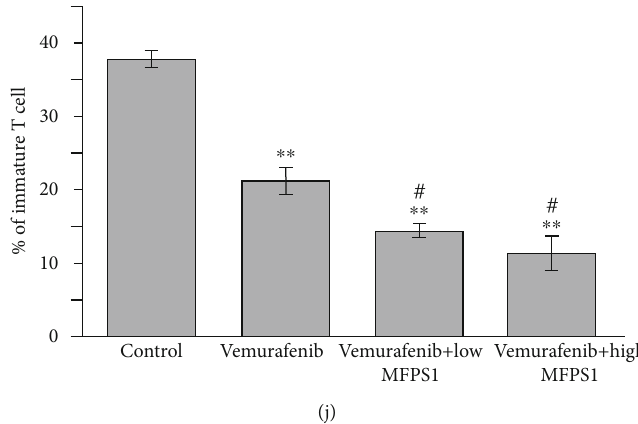
Figure 5: E ff ect of MFPS1 combined with Vemurafenib on immunomodulatory activity in melanoma-bearing mice. Results of immunophenotypic fl ow cytometry for a single mouse (a, c, e, h); (a, b) lymphocyte content in PBMCs of melanoma-bearing mice after drug treatment; (c, d) CD335-positive NK cell content in PBMCs of melanoma-bearing mice; (e, f) the content of mature B cells in PBMCs of melanoma-bearing mice (upper right corner in (e)); (e, g) the content of immature B cells in PBMCs of melanoma-bearing mice (lower right corner in (e)); (h, i) the content of mature T cells in PBMCs of melanoma-bearing mice (upper right corner in (h)); (h, j) the content of immature T cells in PBMCs of melanoma-bearing mice (lower right corner in (h)). ∗ represents the normal group as the control: ∗ p < 0 : 05 and ∗∗ p < 0 : 01 ; # represents the Vemurafenib group as the control: # p < 0 : 05 and ## p < 0 : 01 .